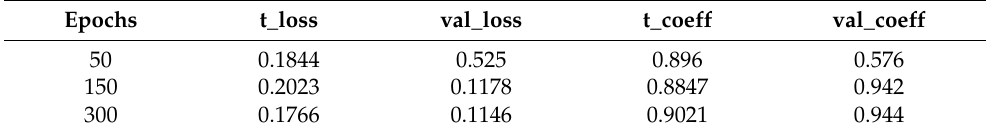
Table 4. Results for the model with Tversky